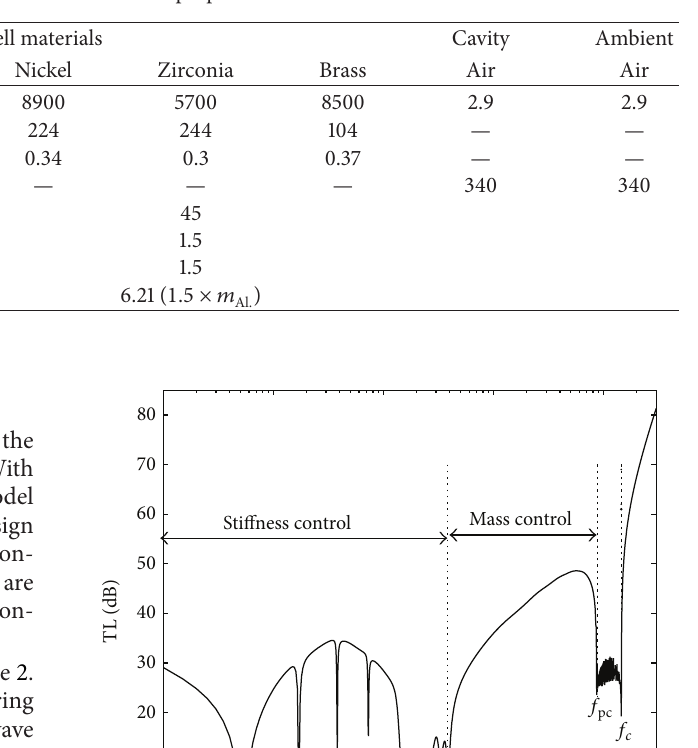
Table 1: Material and environmental properties.